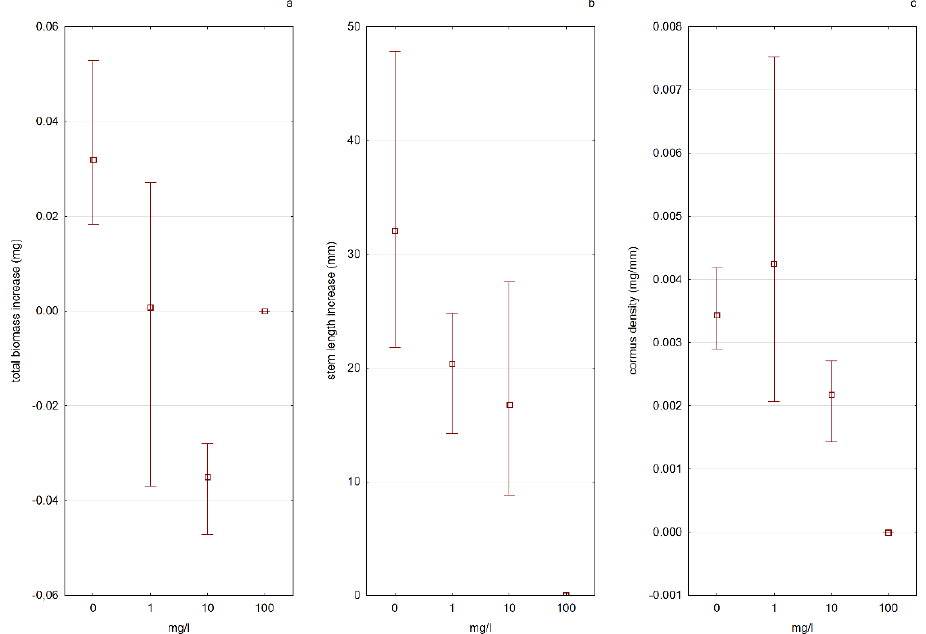
Figure 8. The influence of the available N-NH 4 ions on the tested features of plants, determining the growth efficiency (( a )—total biomass increase, ( b )—stem length, ( c )—cormus density). Whiskers indicate the range of values, and squares indicate the